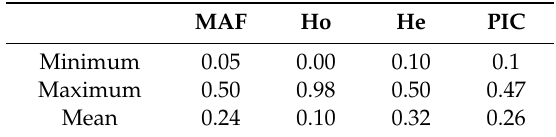
Table 3. Diversity indices of the 150 inbred lines based on 16,735 single-nucleotide polymorphism (SNP) markers. MAF Ho He PIC Minimum 0.05 0.00 0.10